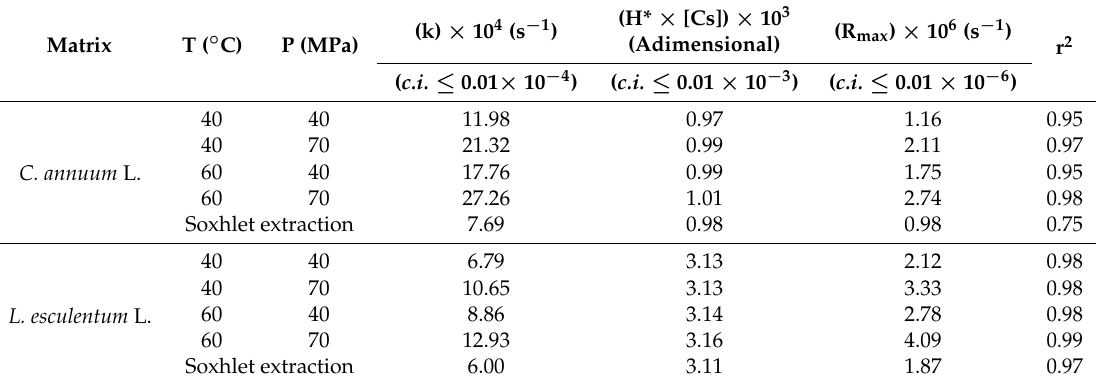
Table 1. Extraction of carotenoids from pepper and tomato. Values were assumed by R max and the equation parameters k and H* × [Cs] as a function of the working conditions. T = temperature; P = pressure; r 2 = square of correlation coefficient ( p = 0.05).